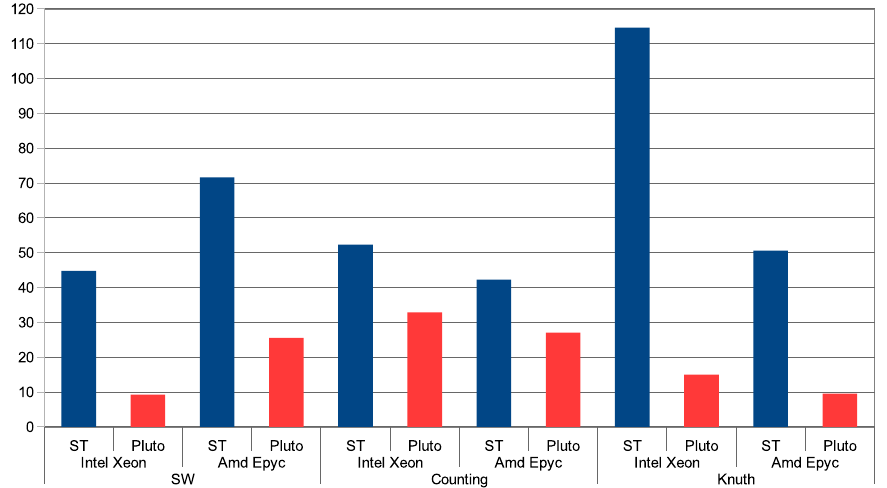
Figure 5. Speedup of tiled codes on a 2 × Intel Xeon 2699 v3 (72 threads) and AMD Epyc 7543 (64 threads) for N =